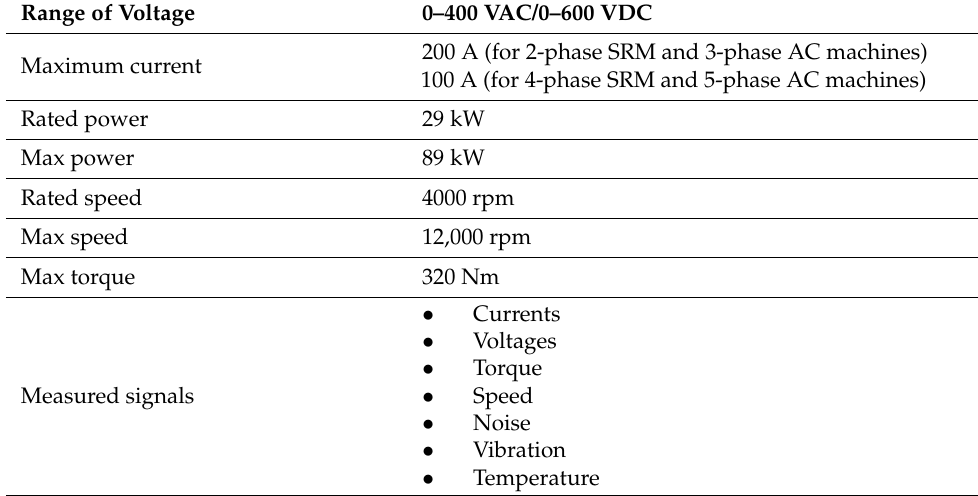
Table 1. Test bench specification.